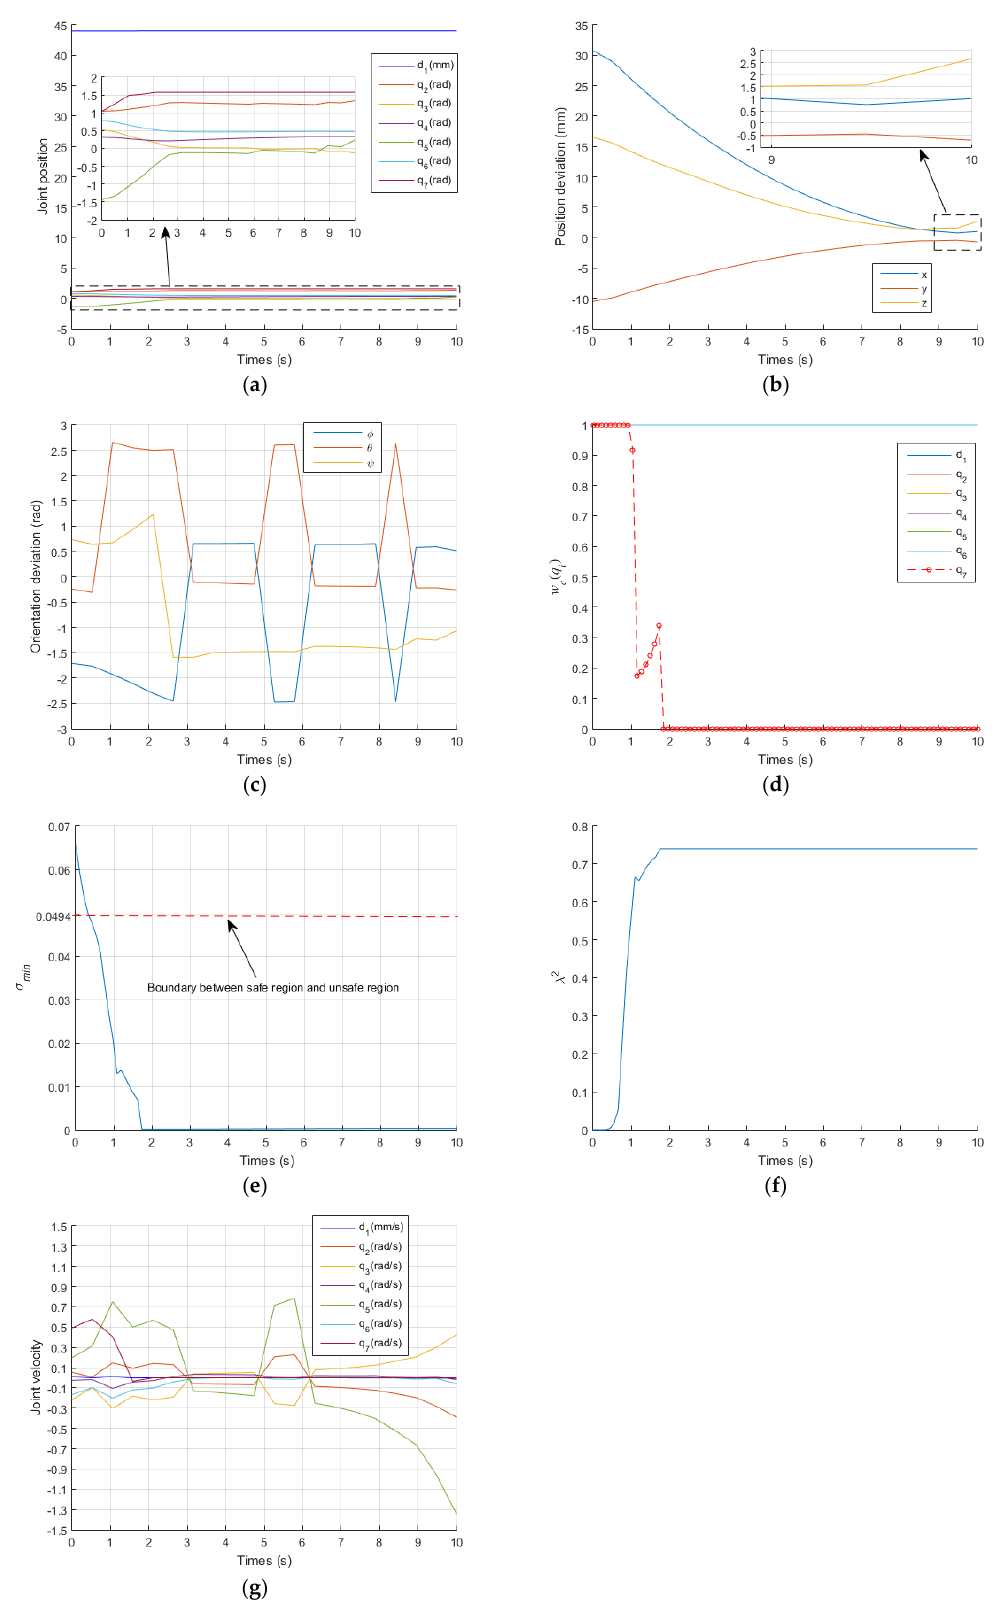
Figure 8. Simulation results obtained with the WLN method. ( a ) the change curve of joint position; ( b ) the change curve of position deviation; ( c ) the change curve of orientation deviation; ( d ) the change curve of w c ( q i ) ; ( e ) the change curve of σ min ; ( f ) the change curve of λ 2 ; ( g ) the change curve of joint